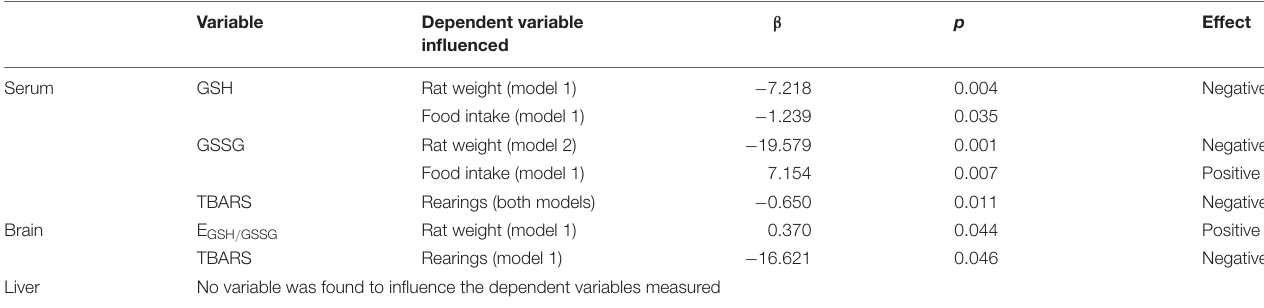
TABLE 3 | Summary of final significant biochemical (oxidative consumption) predictors for biological and behavioral